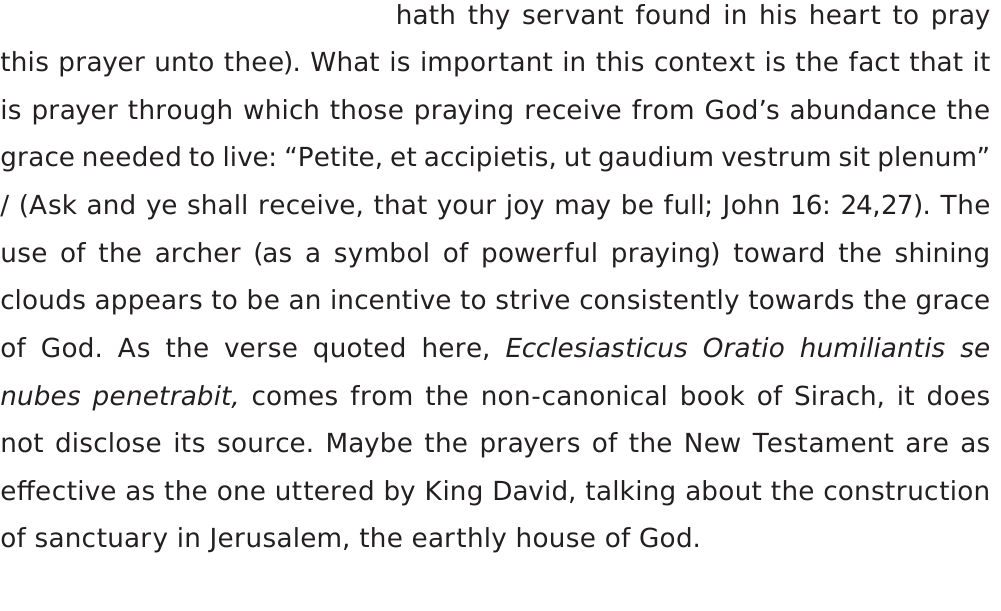
Figure 9 The power of